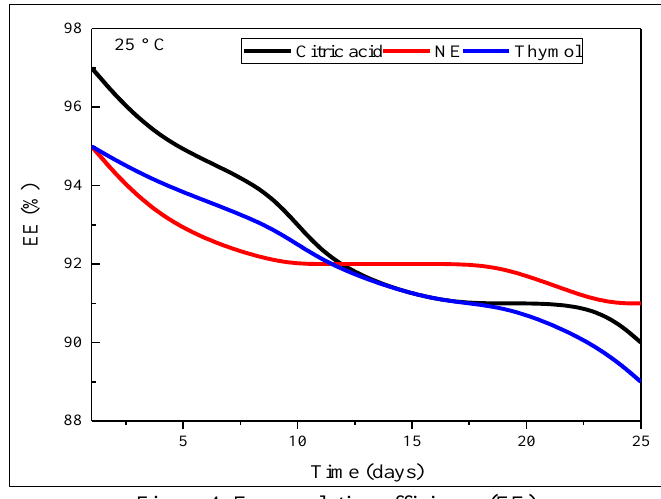
Figure 4: Encapsulation efficiency